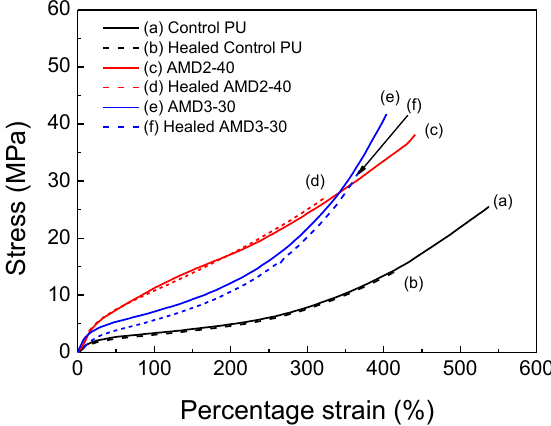
Figure 7. Typical stress–strain curves of PUEs based on AMDs.